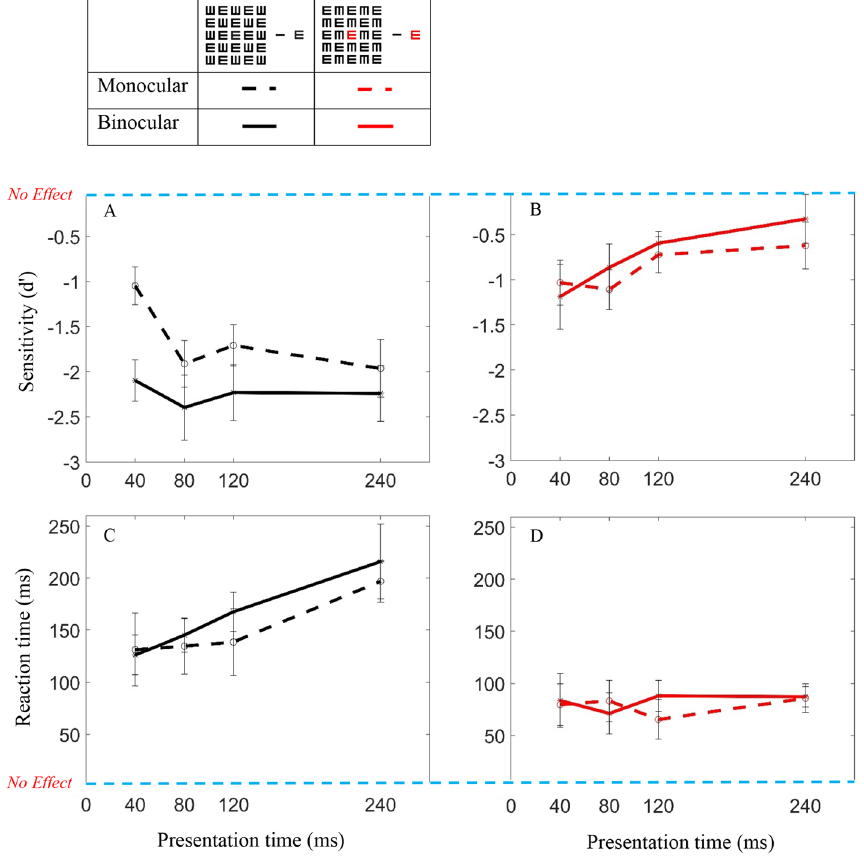
Figure 3. Crowding effect: Sensitivity: ( A ) for a black target. ( B ) For a red target. Reaction time (RT): ( C ) for a black target. ( D ) For a red target. Continuous lines and filled symbols represent binocular vision and dashed lines and open symbols represent monocular vision. Black denotes a black crowding effect and red a red crowding effect. Error bars represent ± SE of the mean.